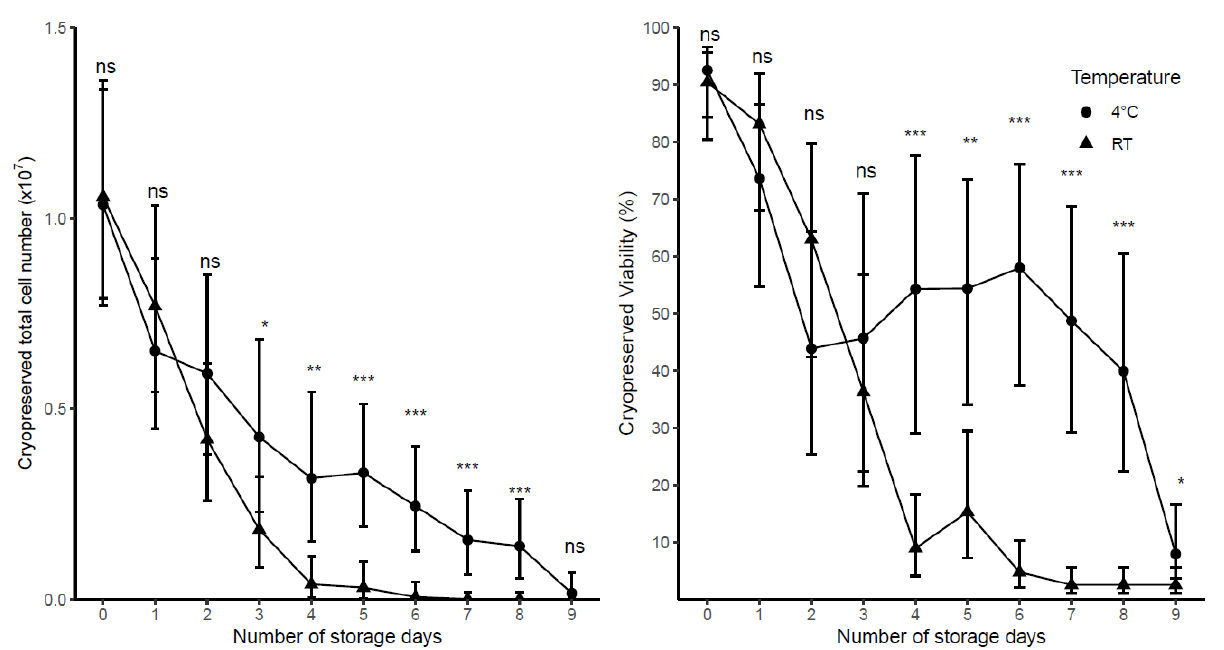
Figure 1. The impact of delaying blood processing on cryopreserved total viable cell number and viability of samples stored at either RT (n = 5 adult samples) or 4 ◦ C (n = 5 adult samples) prior to processing. Cells were prepared for cryopreservation at a cell density of 10 × 10 6 cells/mL. Day 0 represents the day of collection. Each point represents the predicted mean with 95% CI. Significance (LSD) is the difference between 4 ◦ C and RT at a particular day; where ns = not significant, * p < 0.05, ** p < 0.01, *** p < 0.001.